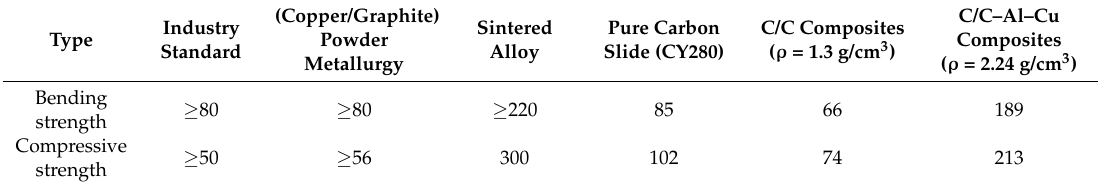
Table 2. Mechanical properties of different pantograph sliders